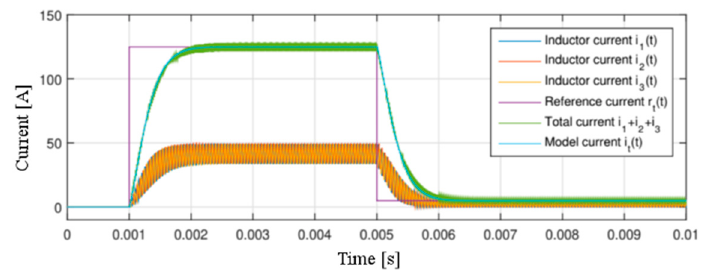
Figure 16. Rising step from 0 A to 125 A and falling step from 125 A to 5 A.